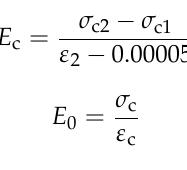
Figure 1. Scheme of axial compression test.